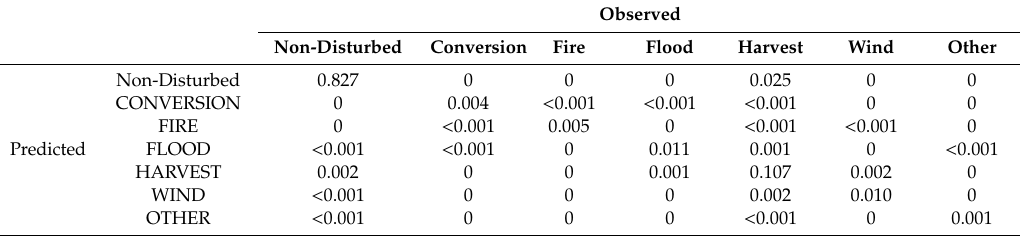
Table 3. The error matrix for disturbance class attribution populated by estimated proportions of area for the Minnesota disturbance map for the period